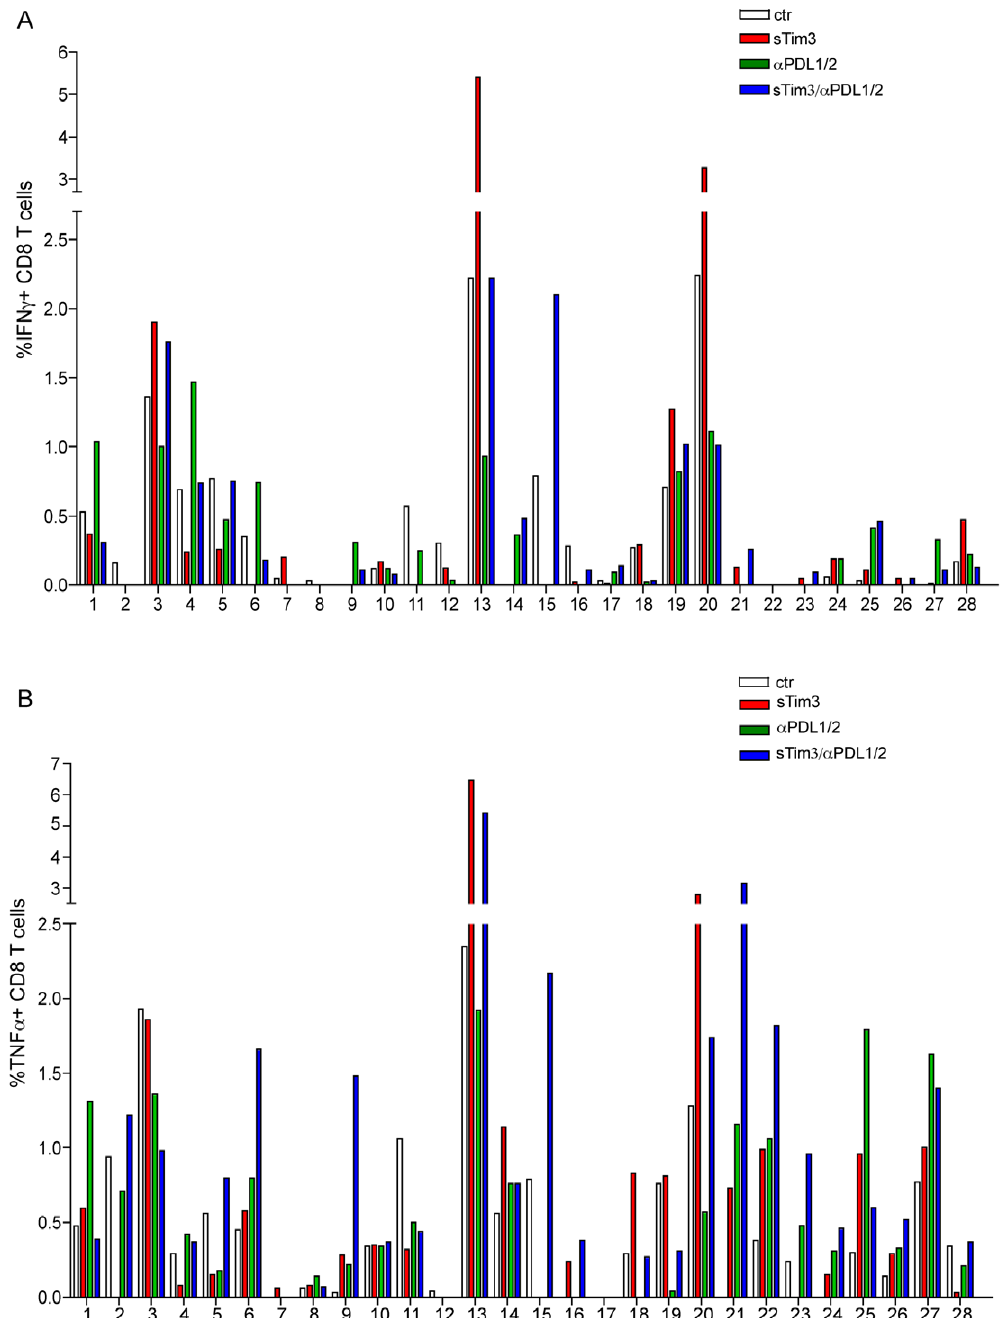
Figure 6. Non-redundant roles for Tim-3 and PD-L1/2 blockade in recovery of functional HBV-specific T cell responses. Summary data from 28 patients with CHB of the percent of HBV-specific CD8 T cells producing IFN- c (a) or TNF- a (b) upon blockade of Tim-3 (red bars), PDL1/L2 (green bars) or dual Tim-3 and PDL1/L2 (blue bars), compared to stimulation with peptides without blocking (white bars).